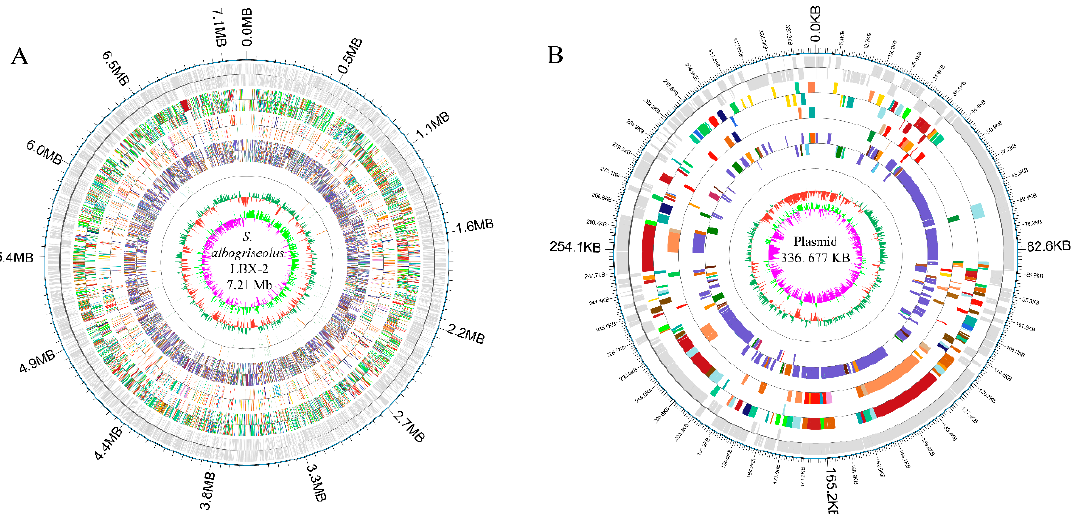
Figure 6. Genomic architecture of S. albogriseolus LBX-2. ( A ) Genome map of S. albogriseolus LBX-2 and ( B ) Plasmid map of S. albogriseolus LBX-2. Each ring, from outside to the center represented the